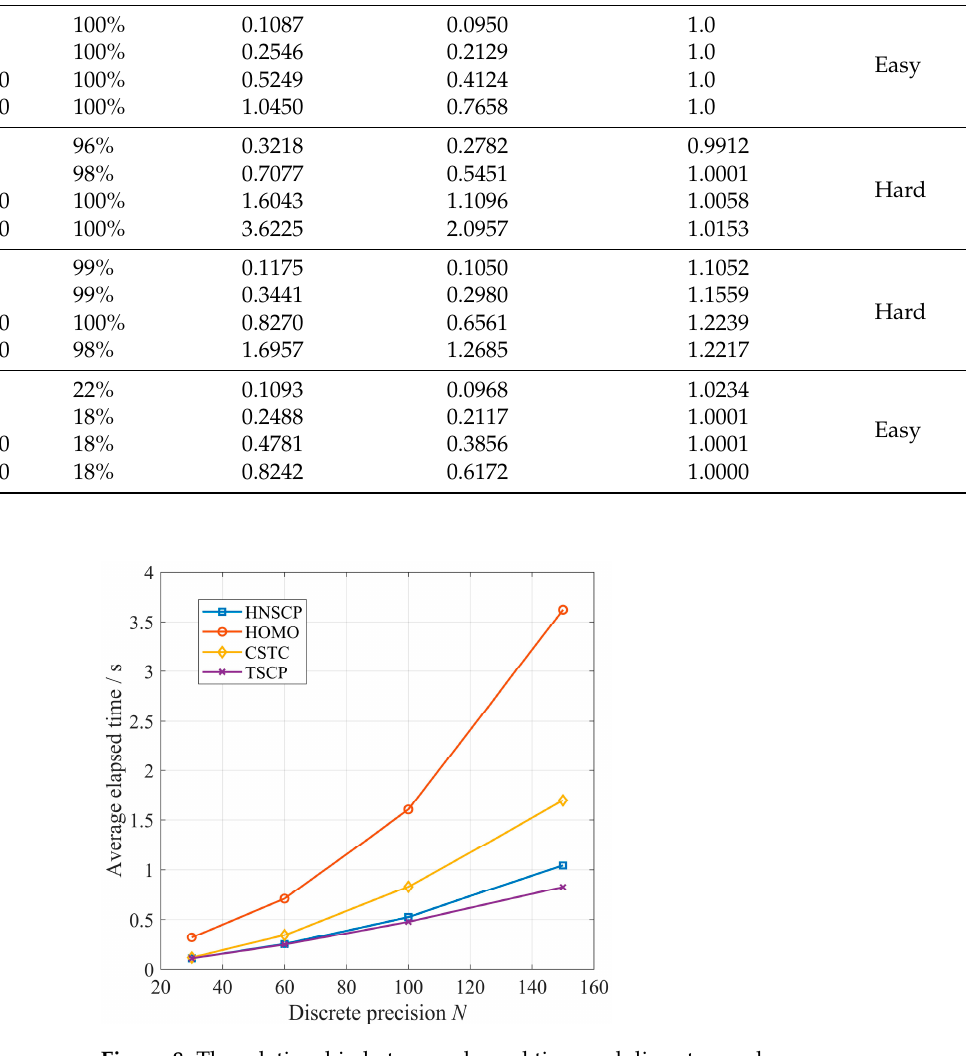
Figure 8. The relationship between elapsed time and discrete number.